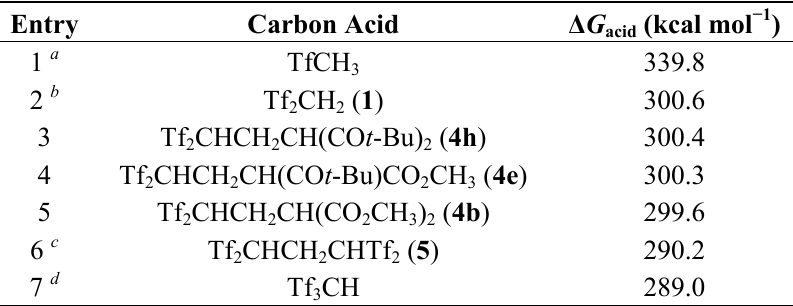
Table 2. The gas-phase acidities of carbon